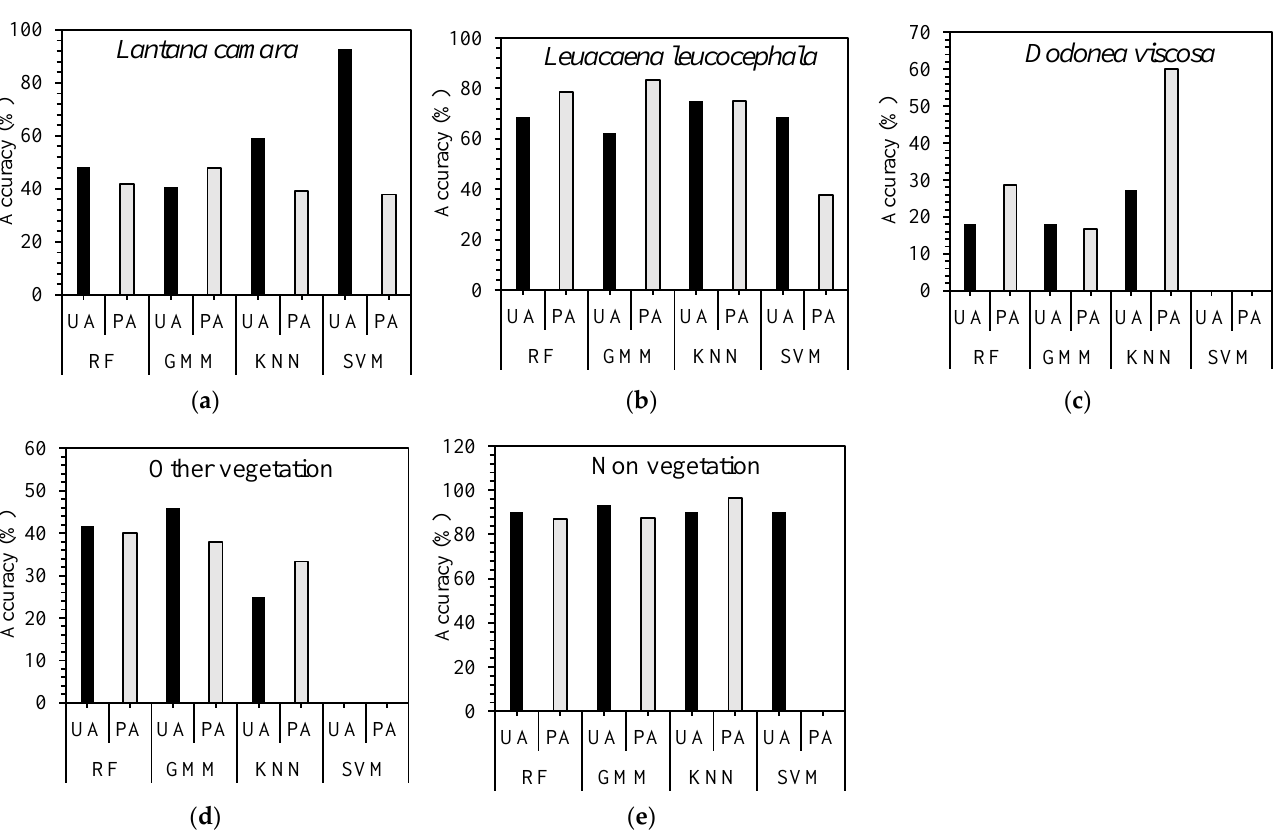
Figure 5. Graphical representation of user accuracy (UA) and producer accuracy (PA) for Sentinel-2 data with all classes. Lantana camara , ( a ) Leucaena leucocephala , ( b ) Dodonaea viscosa , ( c ) other vegetation, ( d ) and non-vegetation ( e ).